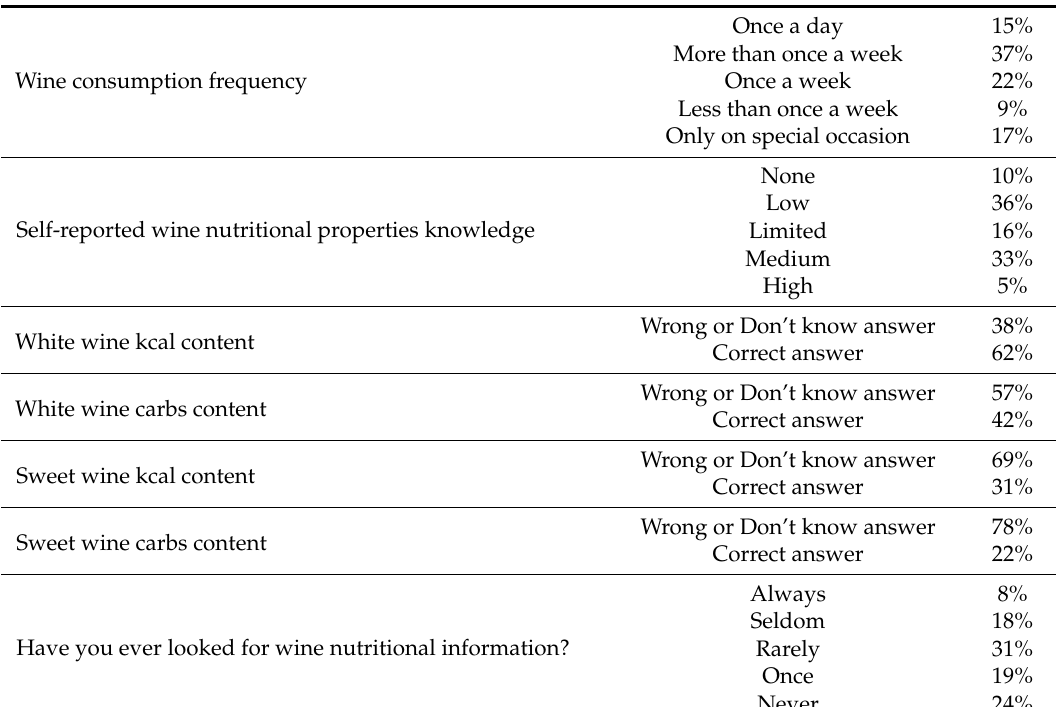
Table 2. Wine consumption variables